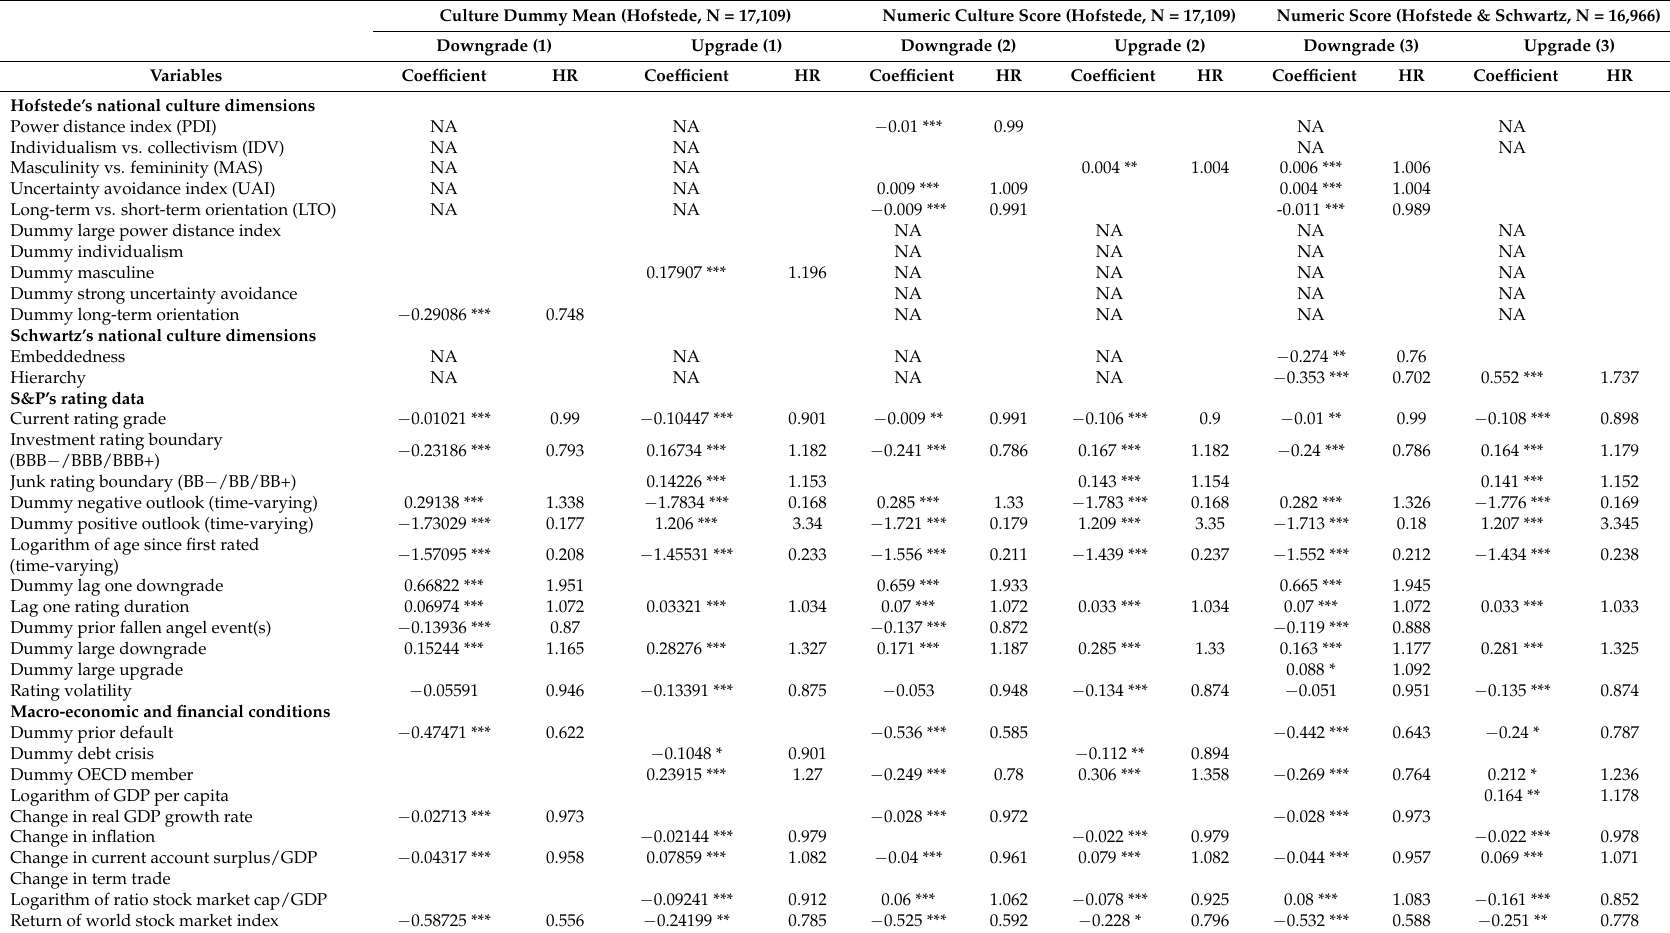
Table 4. Cox’s regression models for rating changes of all